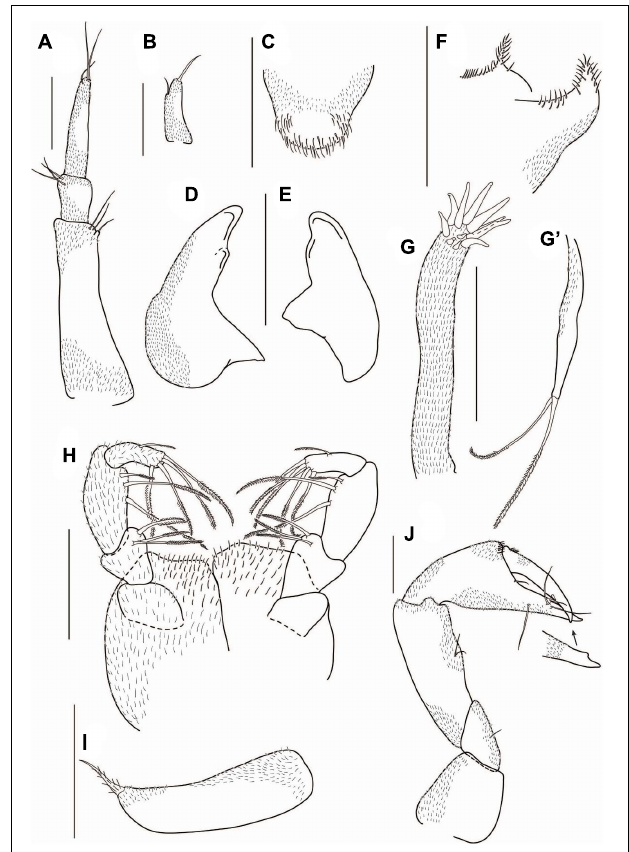
FIGURE 6 | Agathotanais frutosae n. sp., neuter, paratype ( A,F,J : NHM 58034; B–E , G–I : NHM 58035). (A) antennule; (B) antenna; (C) labrum; (D) left mandible; (E) right mandible; (F) labium; (G) maxillule; (G’) palp of maxillule; (H) maxilliped; (I) epignath; (J) cheliped. Scale bars: (C–I) = 10 µ m, (A,B,J) = 100 µ